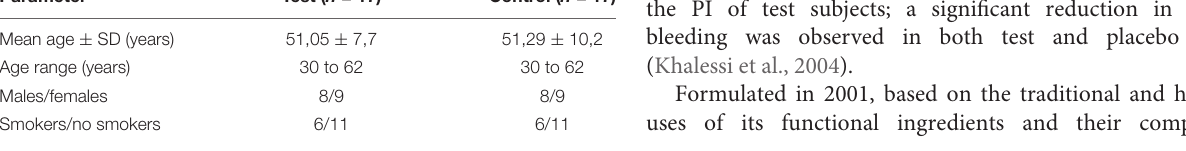
TABLE 1 | Basic demographic characteristics of study population. Parameter